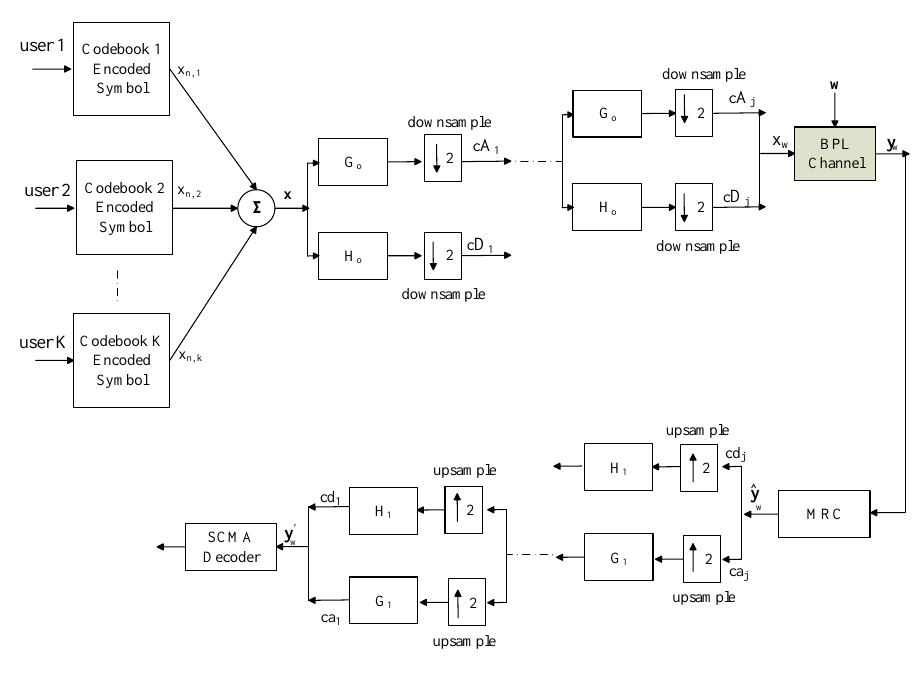
Figure 6. Block diagram of